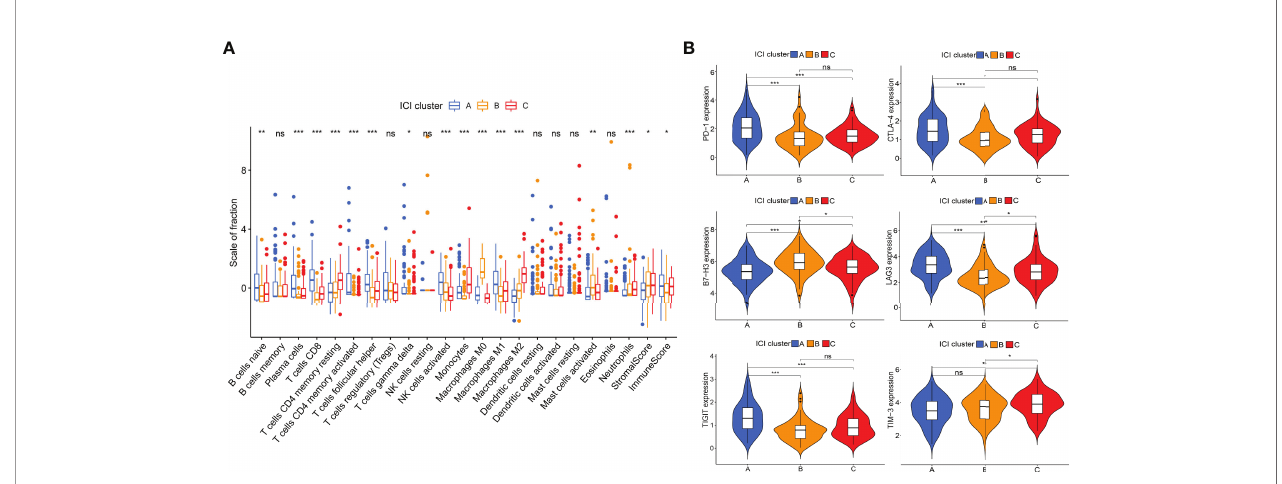
FIGURE 3 | Differential analyses of ICI levels and immune checkpoint genes among ICI clusters. (A) Box diagram of ICI levels. Kruskal-Wallis test. (B) Violin plots of six immune checkpoint genes. Wilcoxon test. * P < 0.05; ** P < 0.01; *** P < 0.001; ns: no signi fi cant.